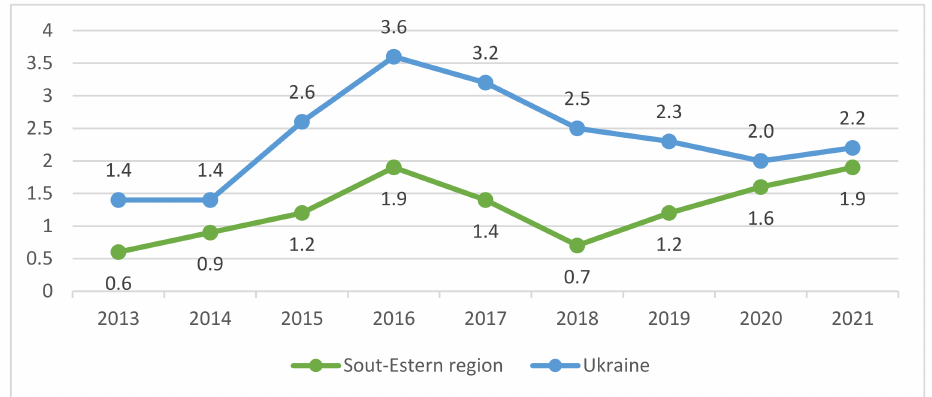
Figure 4. Productivity index of capital investments in the supply of electricity, gas, steam, and air conditioning in the south-eastern region of Ukraine in 2013–2021 (constructed by the authors according to the data [40,41]).